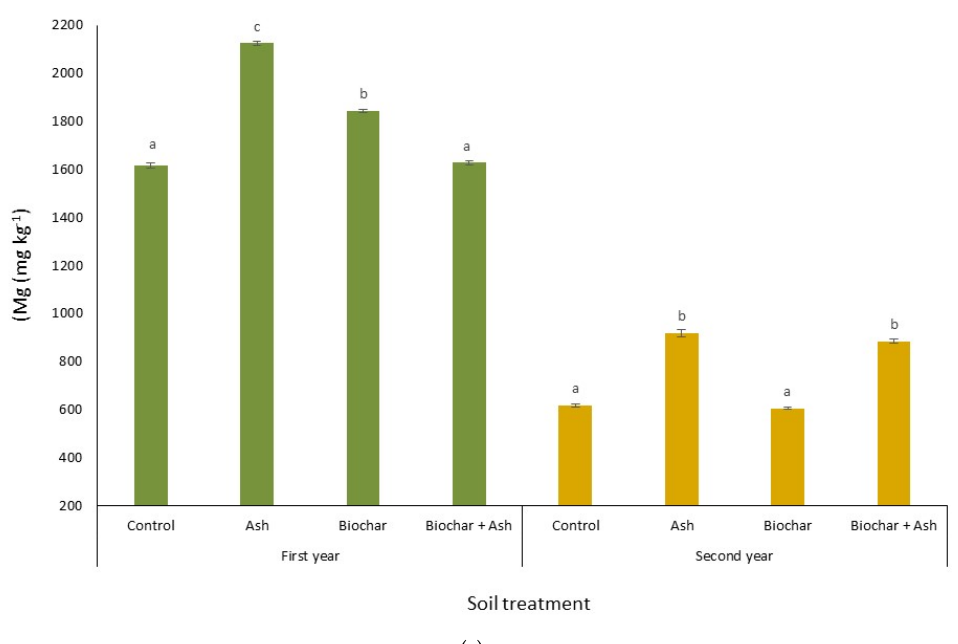
Figure 5. Pyrolysates’ absorbable forms of phosphorus (P 2 O 5- mg kg −1 ) ( a ), potassium (K 2 O-mg kg −1 ) ( b ) and magnesium (Mg-mg kg −1 ) ( c ) contents, produced from basket willow biomass collected from the control, ash, biochar, and biochar + ash soil treatment plots, one and two years after planting ( n = 12). In accordance with the result of the Bonferroni test, the elements’ values were not significantly (α ≤ 0.05) different among treatments (separate comparison for each year).